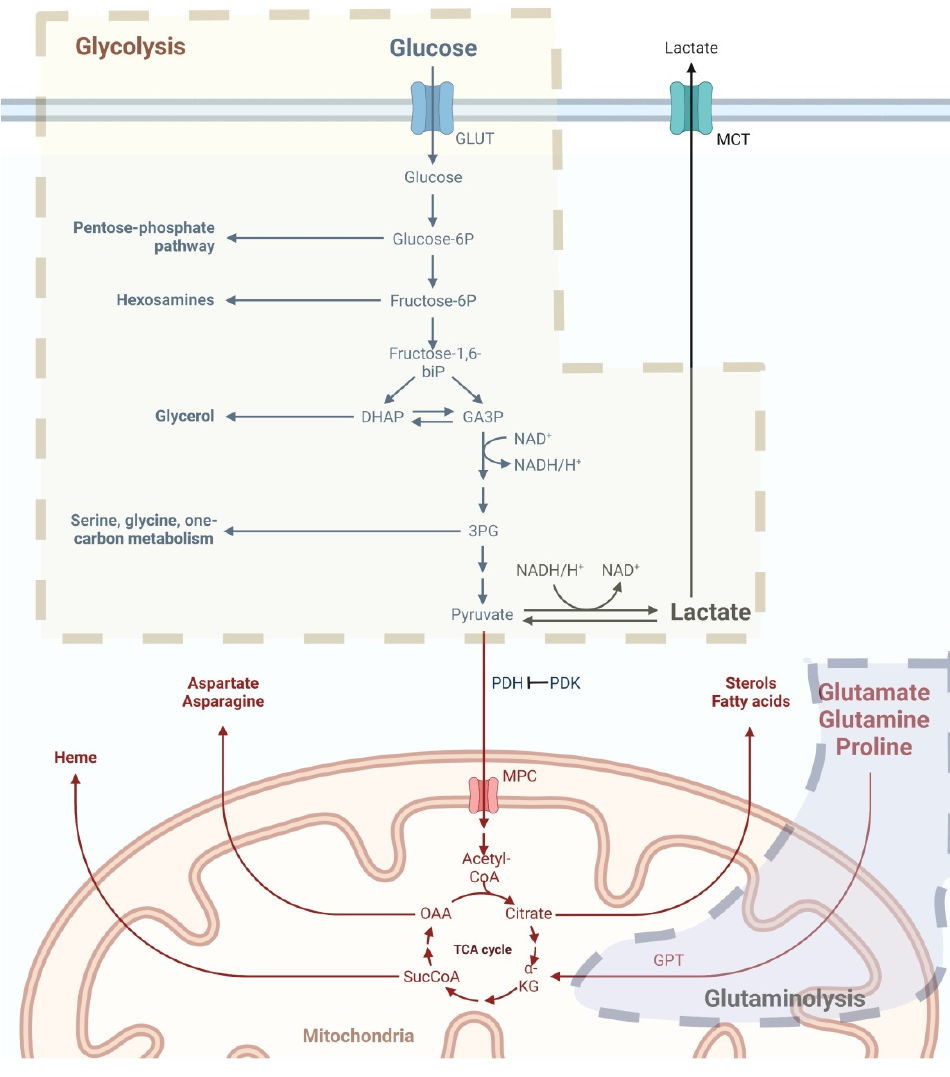
Figure 1. Mitochondria regulate metabolic reprogramming in UC. The major pathways of metabolic reprogramming in UC are enhanced aerobic glycolysis and glutaminolysis. Aerobic glycolysis leads to increased cytosolic lactate production. Glutaminolysis supports cancer cells by providing energy and pools of TCA cycle intermediates for biosynthesis of proteins, lipids, and nucleotides Abbreviations: GLUT, glucose transporter; GPT, glutamate pyruvate transaminase; MCT, monocarboxylate transporter; OAA, oxaloacetate; PDH, pyruvate dehydrogenase; PDK, pyruvate dehydrogenase kinases; TCA, tricarboxylic acid. The figure was created with BioRen- der.com.